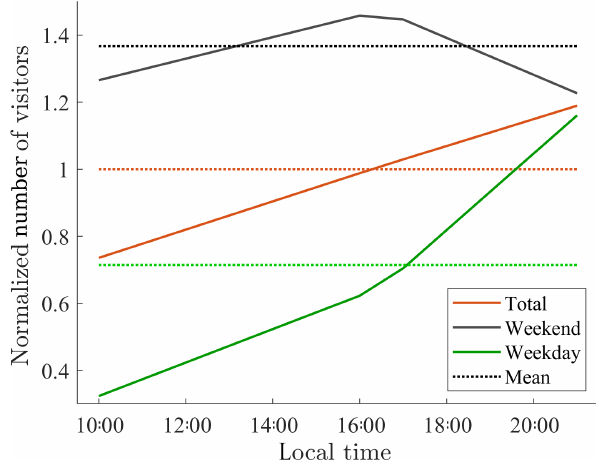
Figure 10. Qualitative daily trend of the number of visitors at Ok- toberfest for the weekend (black), weekday (green), and total (red). The dotted line represents the mean value of each trend